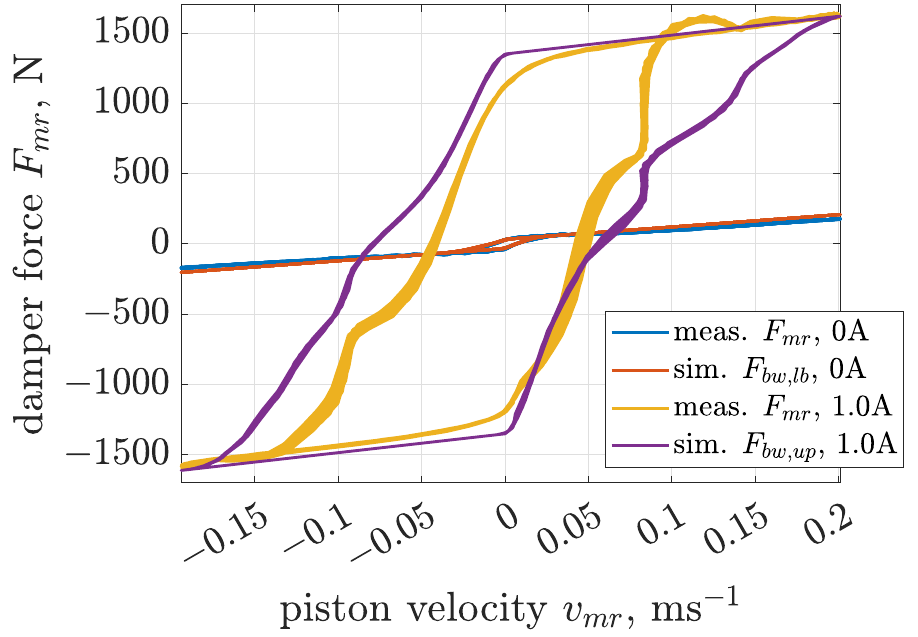
Figure 15. Comparison of force–velocity characteristics obtained for the MR damper and the Bouc–Wen model subjected to the sinusoidal excitation of frequency 6 Hz and displacement amplitude 5